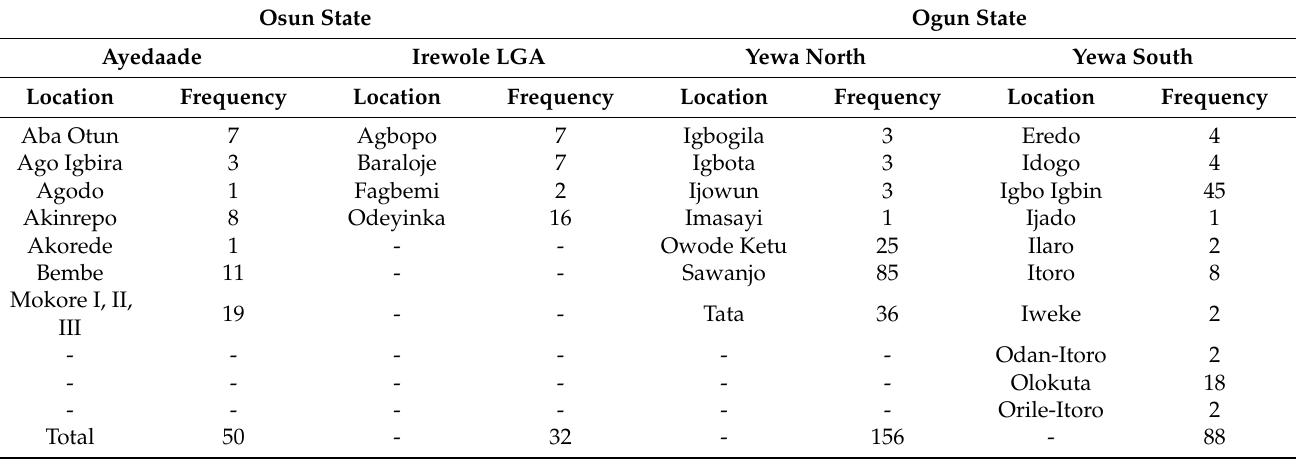
Table 1. Distribution of sampled cocoa farmers across the